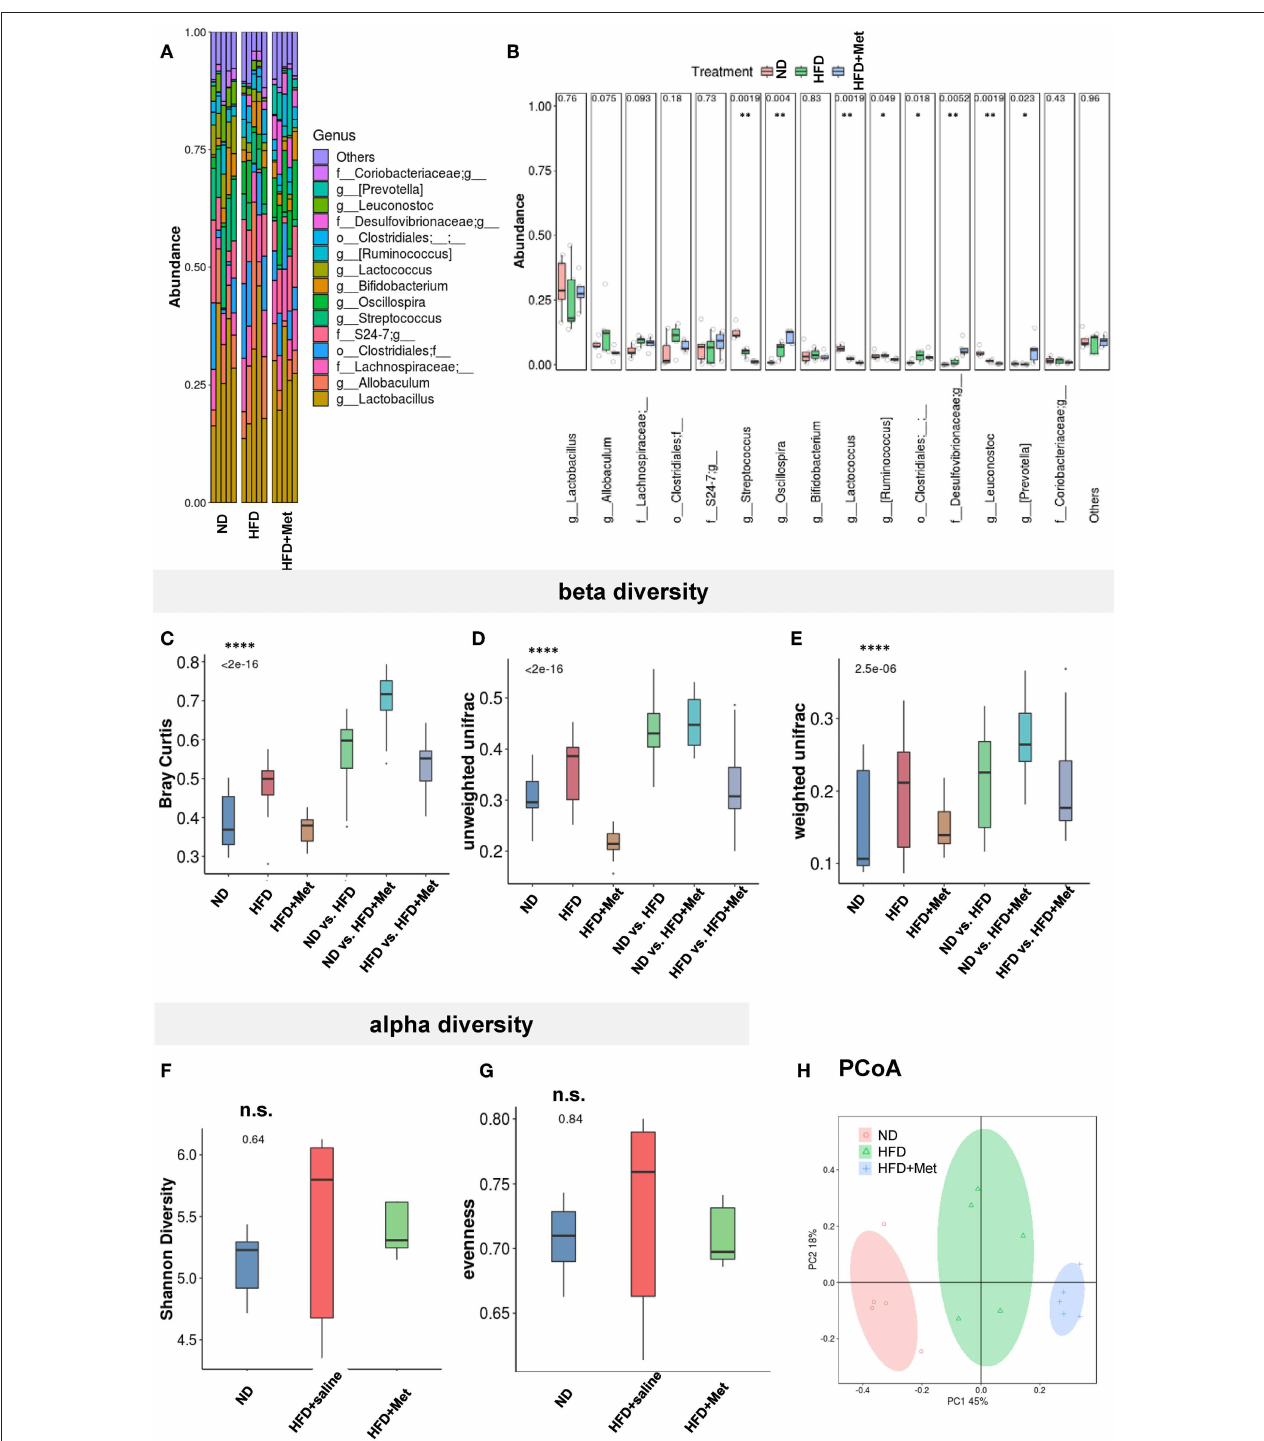
FIGURE 5 | The HFD and HFD + metformin treatments changed microbiota diversity and altered its composition. (A,B) The abundance of species varied among ND, HFD, and HFD + Met group with significant difference for Streptococcus, Oscillospira, Ruminococcus, Leuconostoc, and Prevotella ; (C–E) beta diversity analysis showed significant difference between groups after Bray-curtis dissimilarity, unweighted UniFracand weighted UniFrac analysis (**** p < 0.0001); (F,G) no significant difference was shown by alpha diversity analysis of Shannon’s index or evenness; (H) Principal Co-ordinates Analysis (PCoA) revealed the difference in gut bacteria composition in the three distinct groups. For (A-H) , n = 5 for each group, box and whiskers was plotted; One-way ANOVA with permutation test, * p < 0.05, ** p < 0.01, **** p < 0.0001, n.s. not significant.